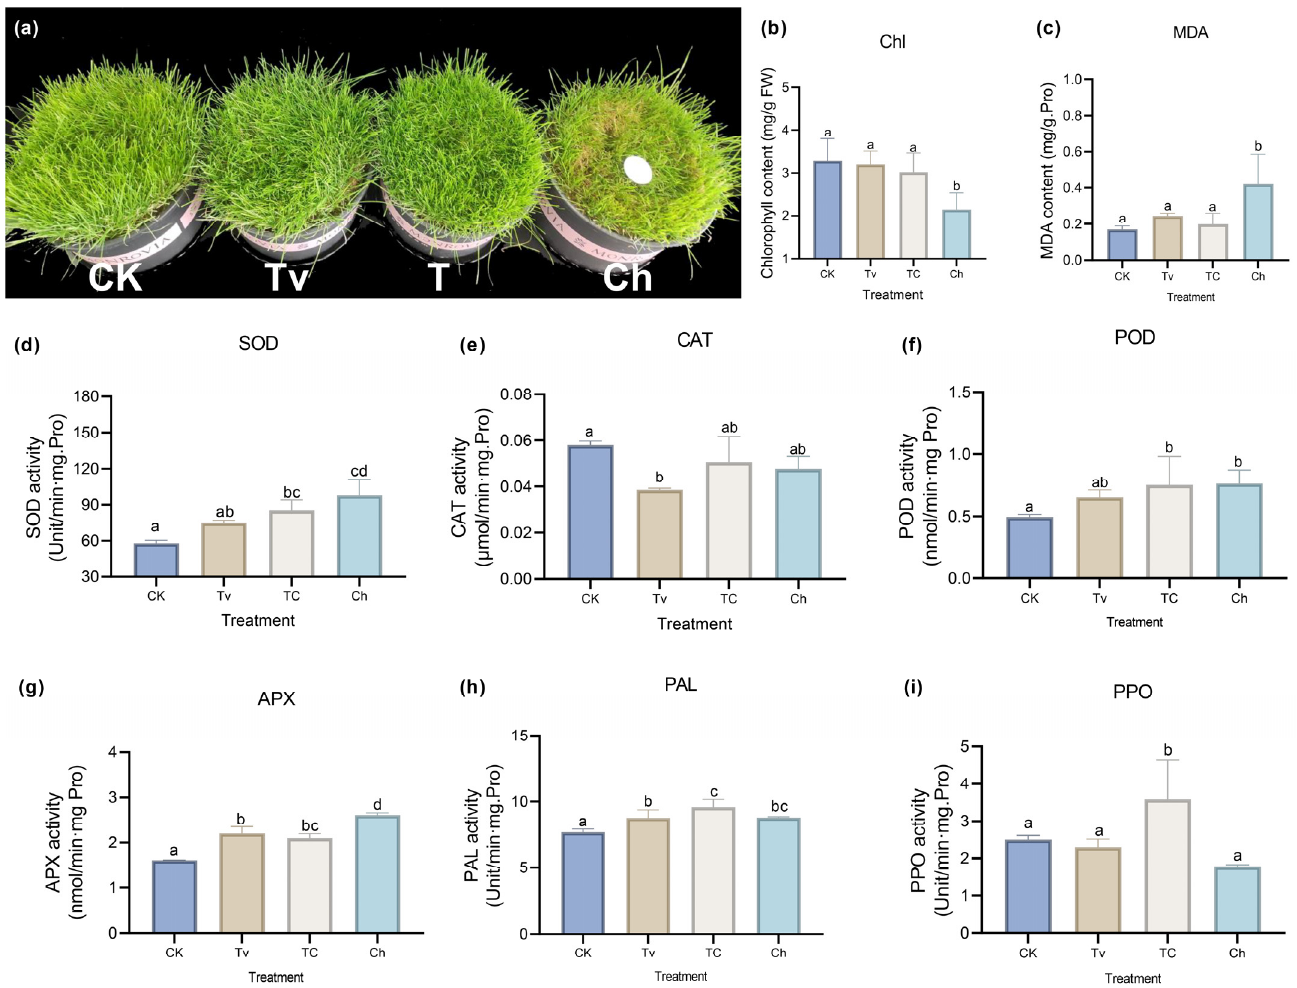
Figure 1. Physiological performance of creeping bentgrass after T. virens treatment and/or inoculation of C. homoeocarpa at 19 dpi. CK, plants with well-watered without any treatment; Tv, plants with the pretreatment of T. virens ; TC, plants treated with T. virens pretreatment and C. homoeocarpa infection; Ch, plants treated with C. homoeocarpa infection (the below is the same). ( a ) Photos of creeping bentgrass after various treatments in pots. ( b , c ) Chlorophyll and MDA content. ( d – g ) The activity of antioxidants: SOD, POD, CAT, APX. ( h , i ) The activity of pathogen-related enzyme: PAL, PPO. Different letters aboved were used to indicate means that differ significantly ( p < 0.05).